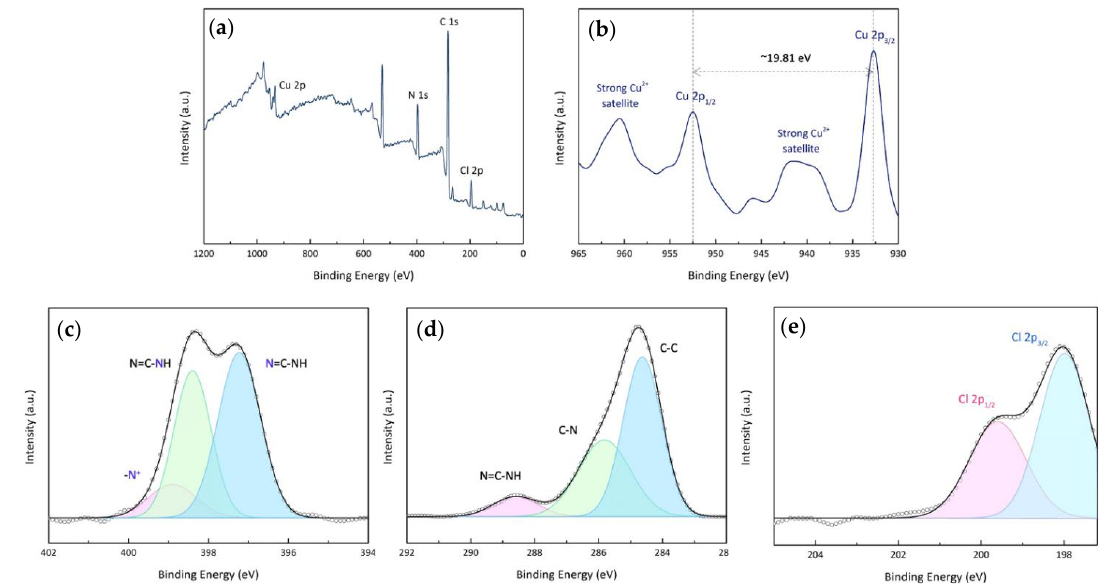
Figure 4. XPS spectra of Cu(C 3 N 2 H 4 ) 4 Cl 2 showing wide spectrum and binding energy states in ( a ) wide scan, ( b ) Cu 2p, ( c ) C1s, ( d ) N1s and ( e ) Cl2p orbitals.